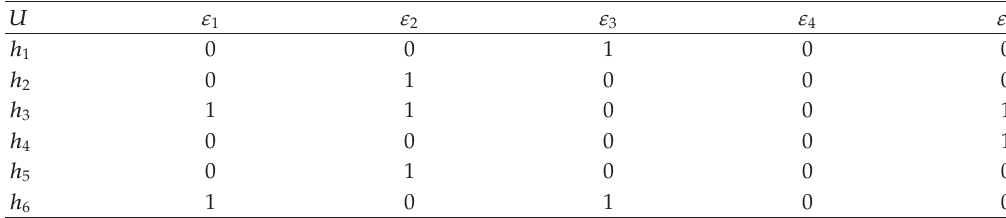
Table 6: Tabular representation of the level soft set L (cid:5) S ; α (cid:6) ,λ (cid:6) (cid:6) . U ε 1 ε 2 ε 3 ε 4 ε